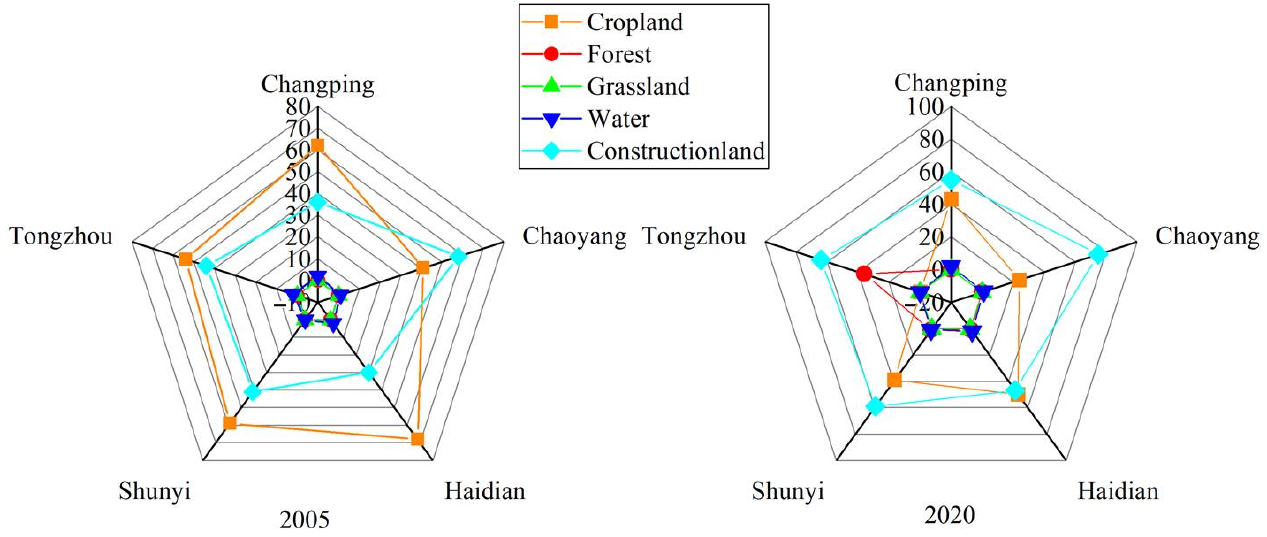
Figure 11. Proportion of land use types in the five subsidence areas of Changping, Haidian, Shunyi, Tongzhou, and Chaoyang.